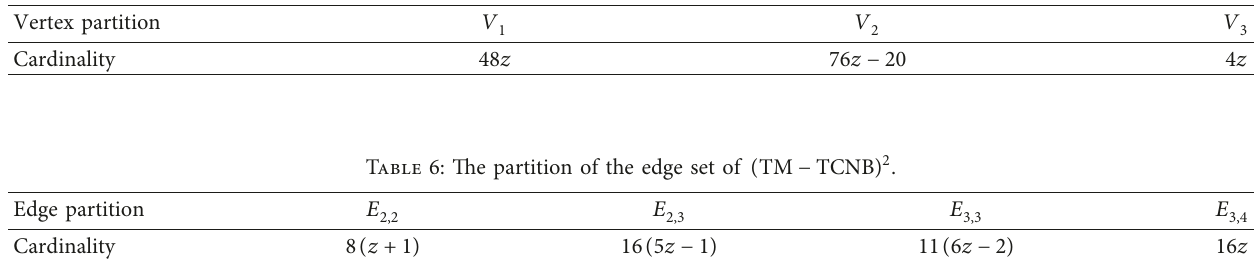
Table 5: The partition of the vertex set of ( TM − TCNB ) 2